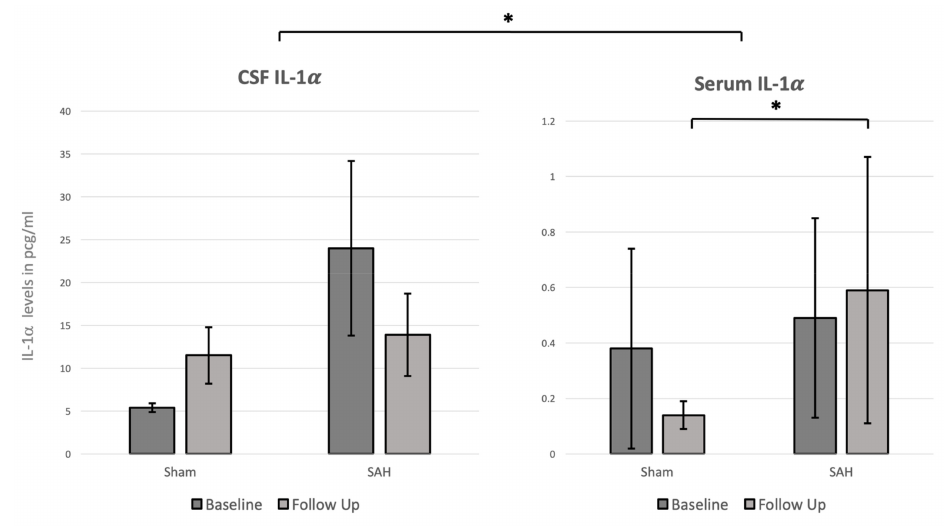
Figure 3. Mean baseline and follow-up IL-1 α cerebrospinal fluid (CSF) and serum levels in pcg / mL. Note that the overall CSF IL-1 α values were significantly higher as compared to the serum IL-1 α levels. Moreover, the serum levels at follow up were significantly higher in the SAH group as compared to the sham group. Data are presented as mean ± SD, *: p <